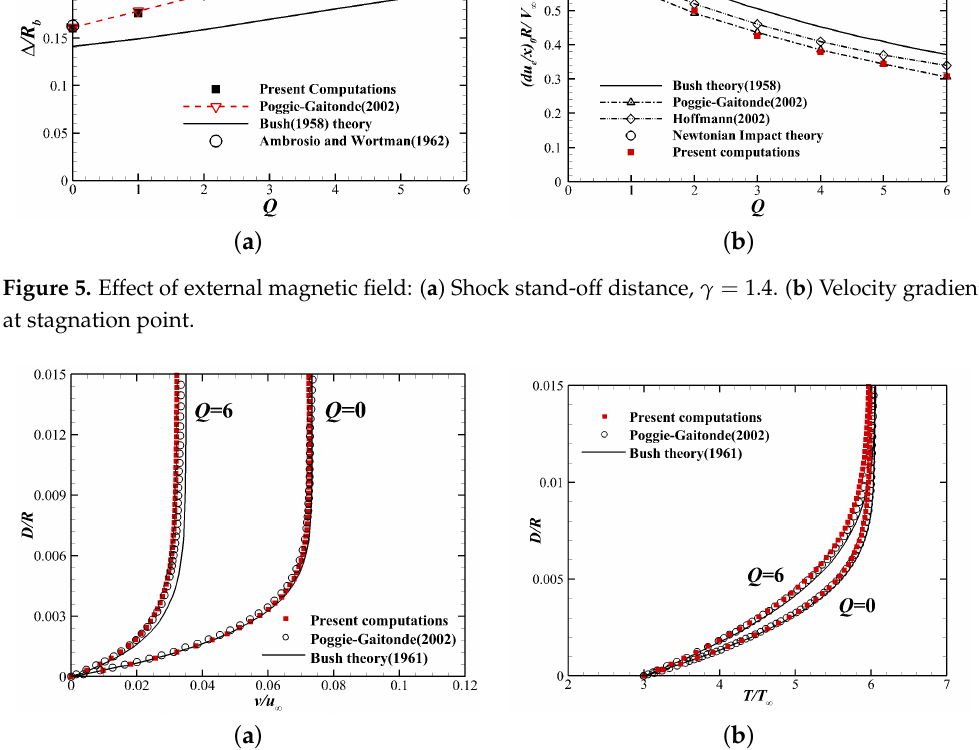
Figure 6. Boundary layer profiles at θ = 6.6 ◦ : ( a ) Streamwise velocity. ( b )